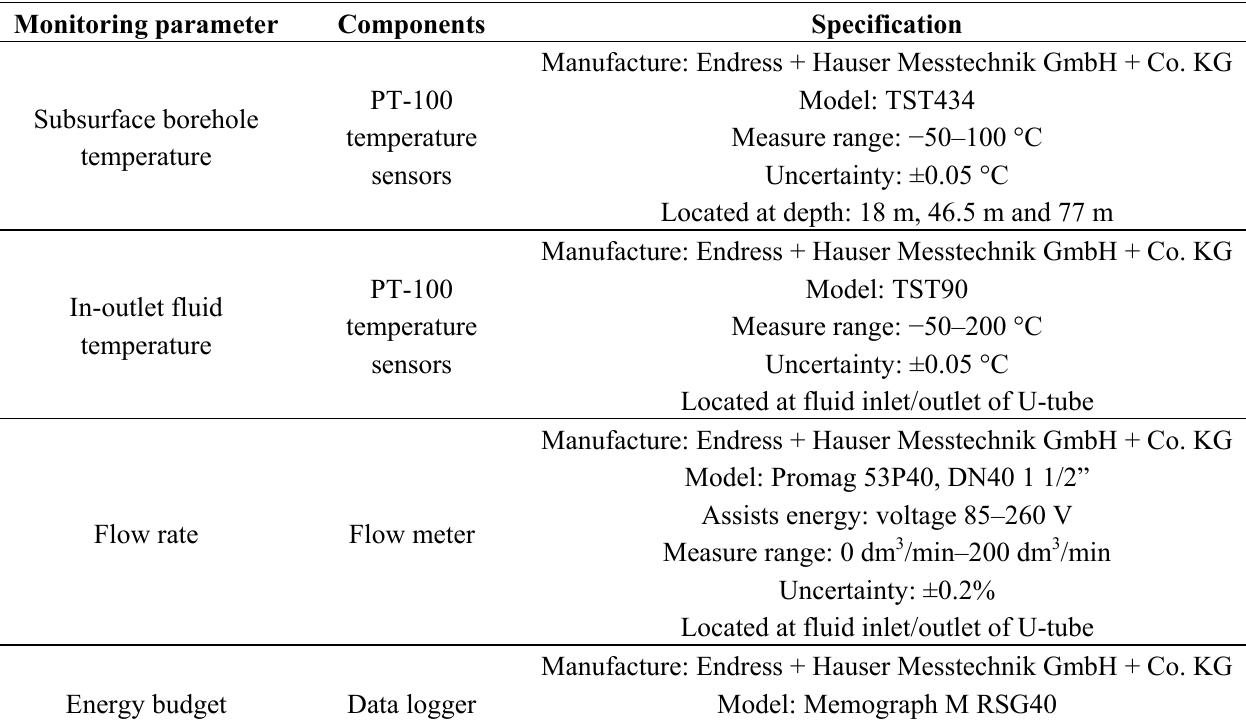
Table 4. The installed temperature sensors and flow meters